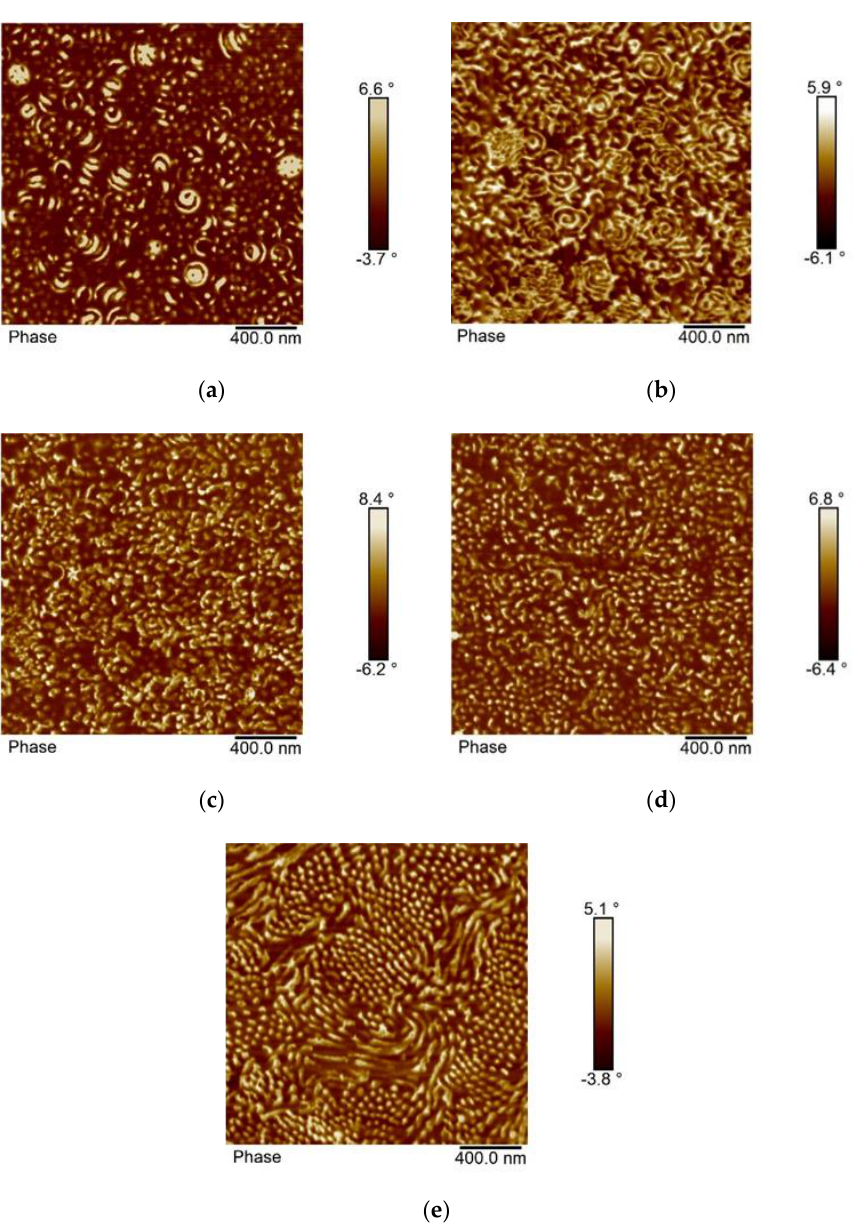
Figure 9. AFM phase images of the sample p(St30/2EHA100). ( a ) Top surface of the latex film dried at room temperature; ( b ) cross-section of the latex film dried at room temperature; ( c ) cross-section of the latex film dried at room temperature and annealed at 100 °C for 30 min; ( d ) cross-section of the latex film dried at room temperature and annealed at 100 °C for 96 h; and ( e ) cross-section of a film cast from THF solution.